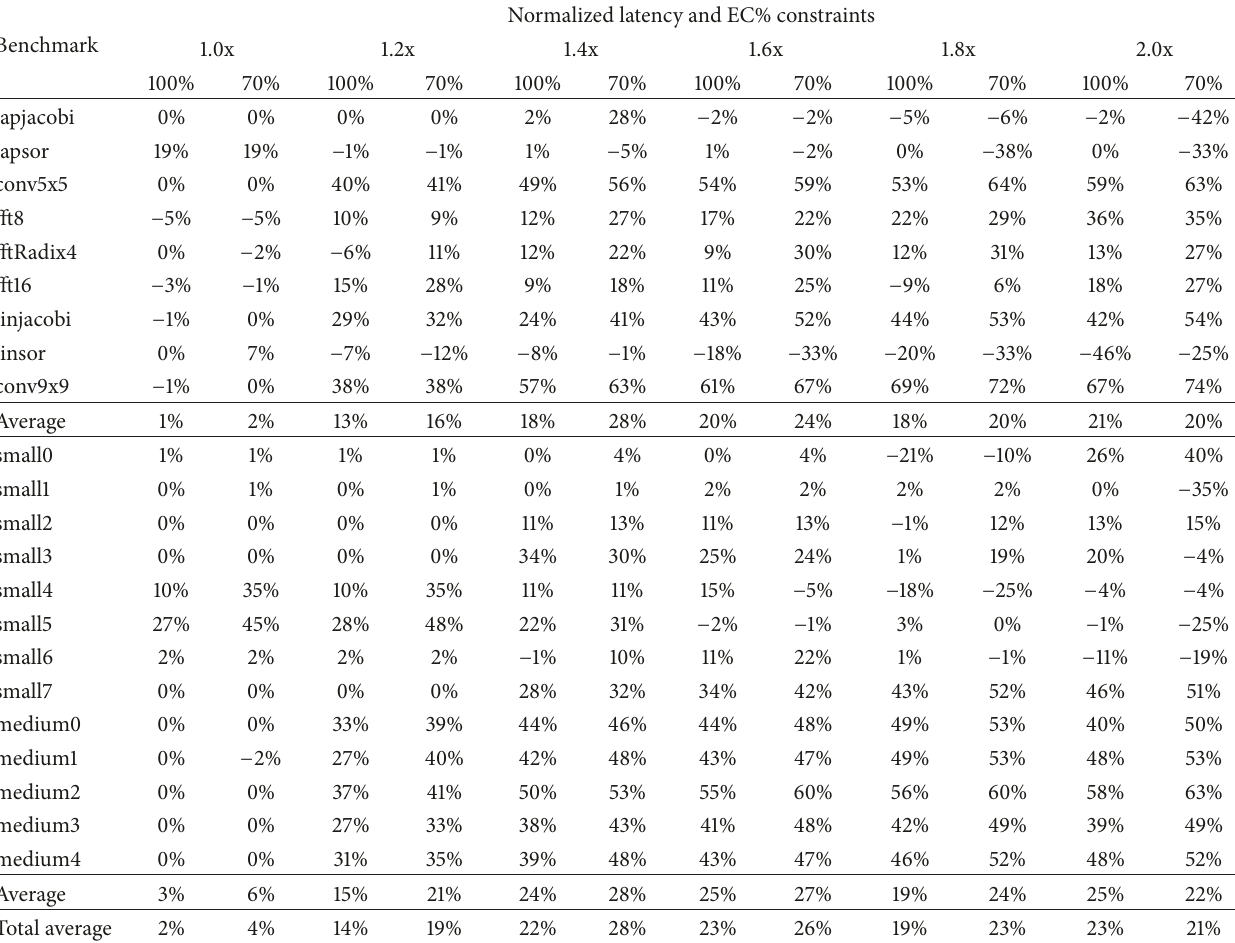
Table 3: Resource savings (LUTS) of FD-FTA heuristic compared to previous work for 100% and 70% EC. Benchmark